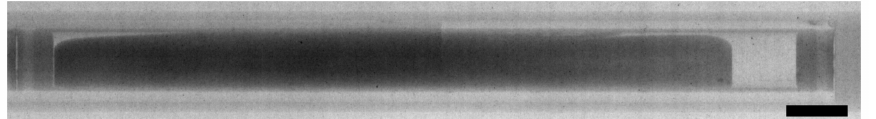
Figure 12. Change of the Pb distribution in SINQ target rod (outer diameter approximately 10 mm) due to the irradiation during operation oriented as inside the SINQ target; compared to the virgin status (see Figure 9) there is an accumulation in the center and ensued filling of the gap to the cladding. The scale bar corresponds to 10 mm.